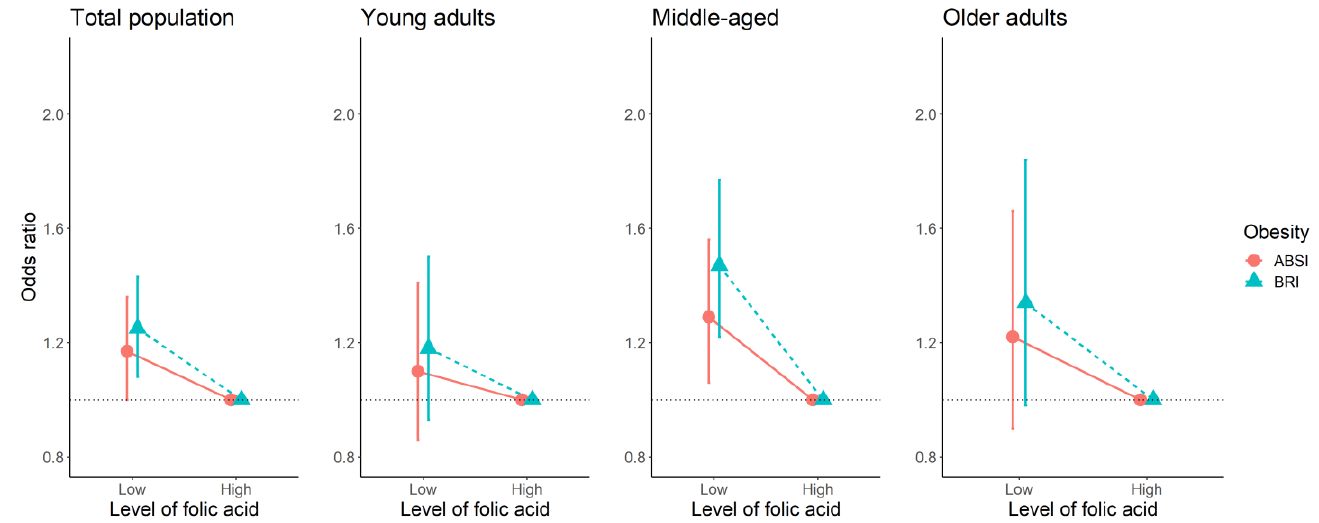
Figure 3. The association between the binary of folic acid and new obesity indices (ABSI, BRI) in each age group using multivariate logistic regression. Abbreviations: ABSI, a body shape index; BRI, body roundness index.